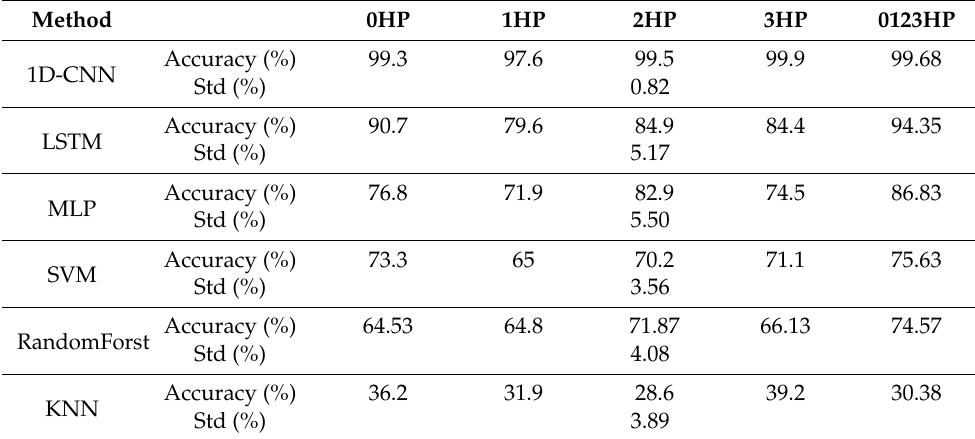
Table 4. Accuracy and Std of different models under different loads.